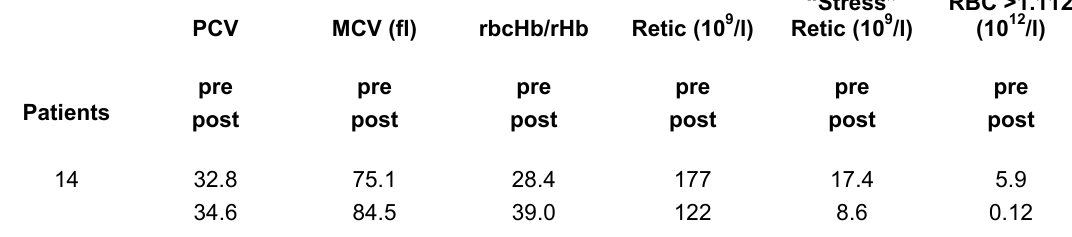
“Stress” RBC >1.112 Retic (10 9 /l) (10 12 /l)